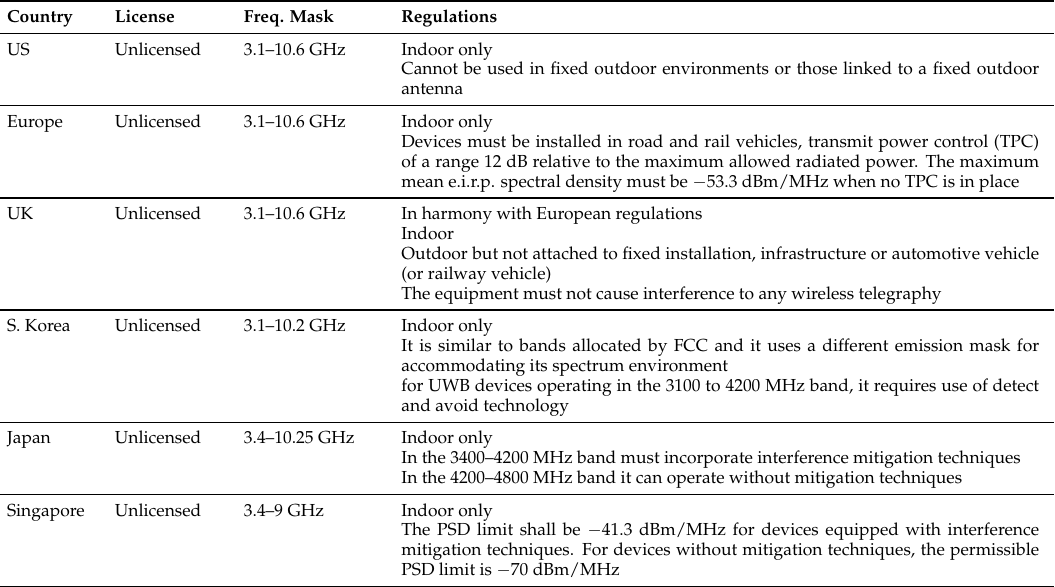
Table 6. Policies and regulations enforced by different